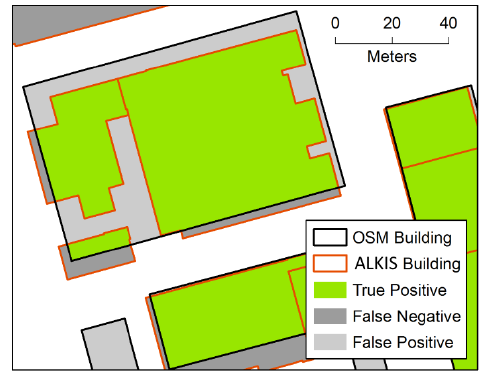
Figure 3. Building polygons from OSM (black outline) and the reference data set ALKIS (red outline). Green areas highlights true positives (building areas overlapping in both data sets), dark-grey indicates false negatives (reference building areas not mapped in OSM) and light-grey depict false positives (OSM building areas not mapped in the reference data set). Here as an example from an industrial area in